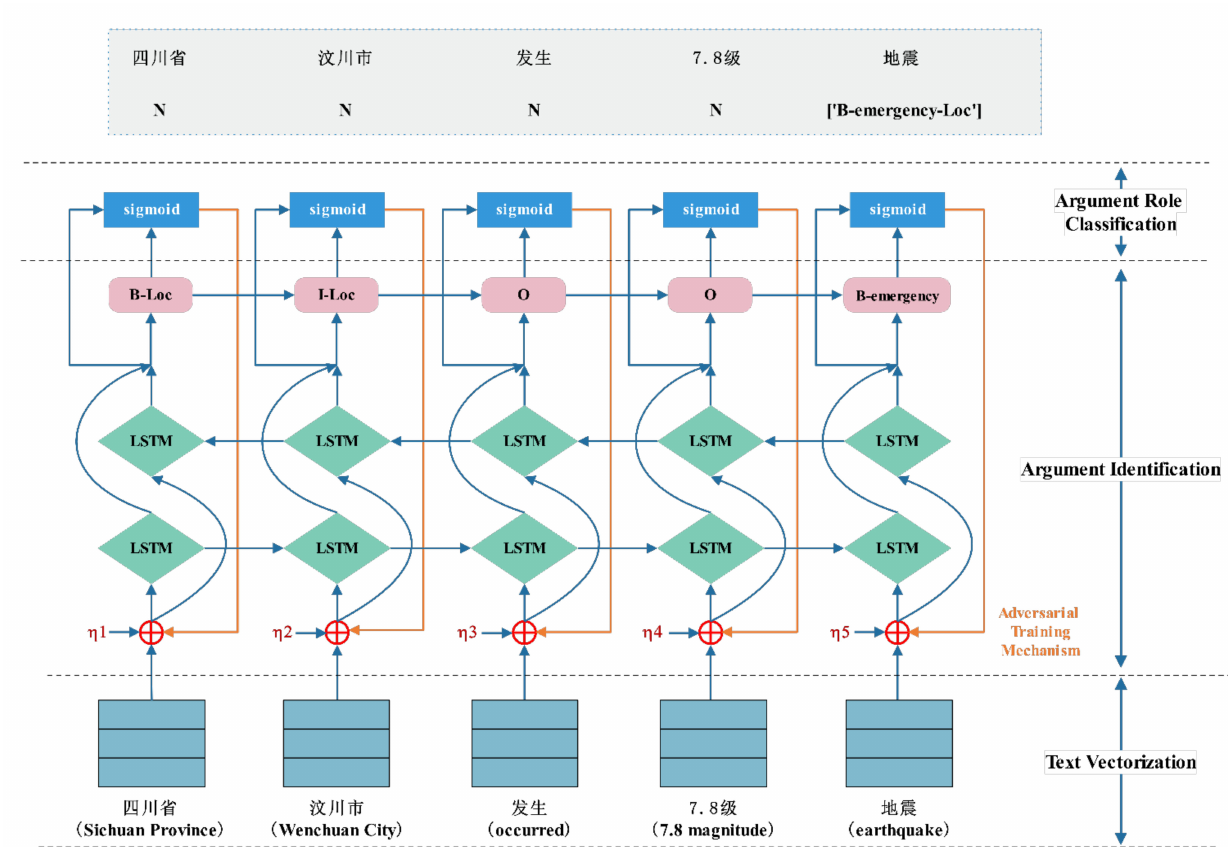
Figure 4. The model structure of